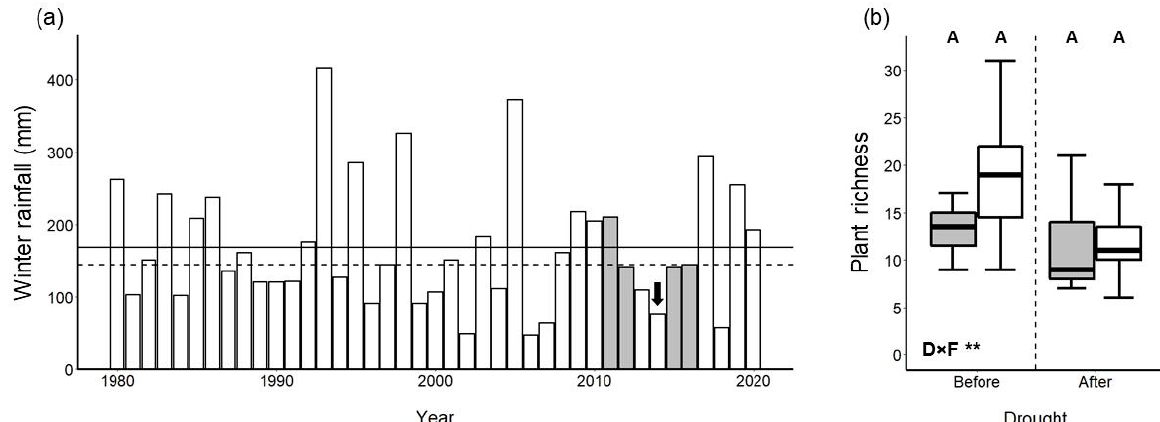
Figure 2. Biotic and abiotic context of native bee surveys. Bar plot ( a ) depicts rainfall in the San Diego region accumulated through the winter months (Nov–Feb inclusive) preceding the spring of each calendar year, with years of bee surveys depicted in gray bars. The black arrow depicts the severe drought event of 2014; solid and dotted horizontal lines depict 40-year mean and median winter rainfall in the period of 1980–2020, respectively. Box plot ( b ) depicts plot-level species richness of entomophilous plants that bloomed in scrub reserve plots (gray boxes) and scrub fragment plots (white boxes) during the timeframe of our surveys. Boxes show central 50% of data; bold horizontal lines represent the median; whiskers extend from the quartiles to 1.5× the interquartile range (or most extreme values of data, whichever is closest to median). Different letters above the boxes indicate treatment combinations that are statistically distinct from one another ( p < 0.05) in post-hoc pairwise tests. Statistical significance of the interaction between drought status and fragmentation status (“D×F”) is provided: ** p ≤ 0.01.